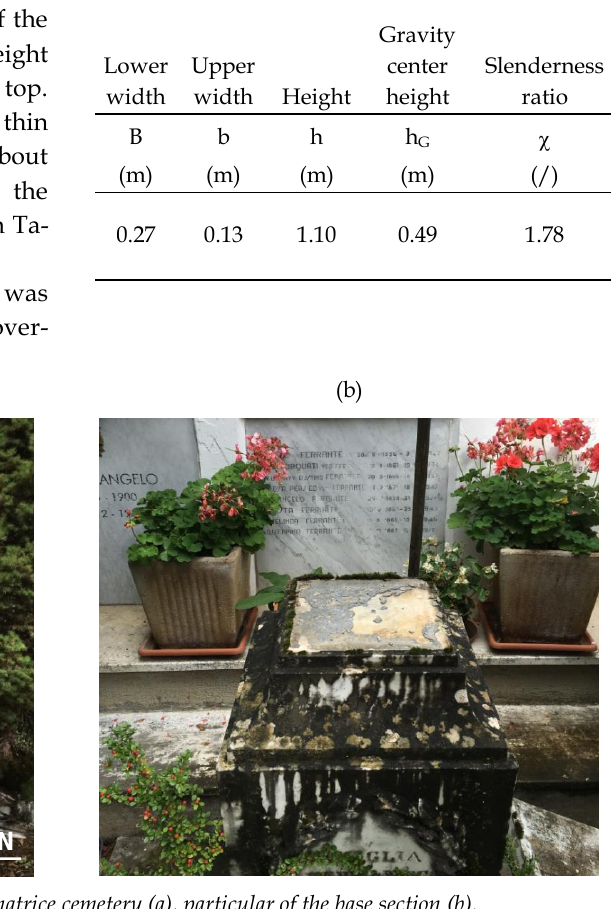
Table 1 . Geometrical parameters of the obelisk.